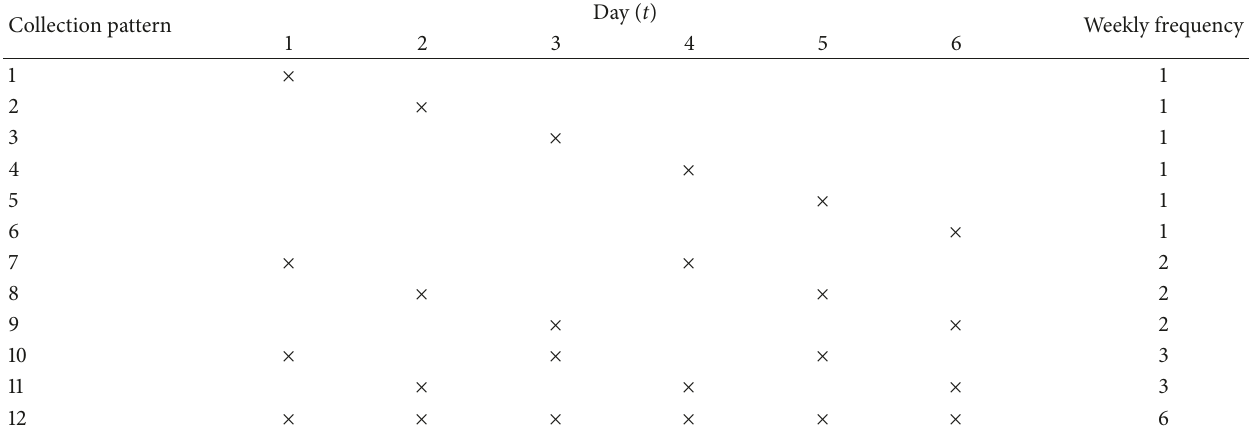
Table 1: Visit patterns 𝑝 considering visit day 𝑡 and weekly